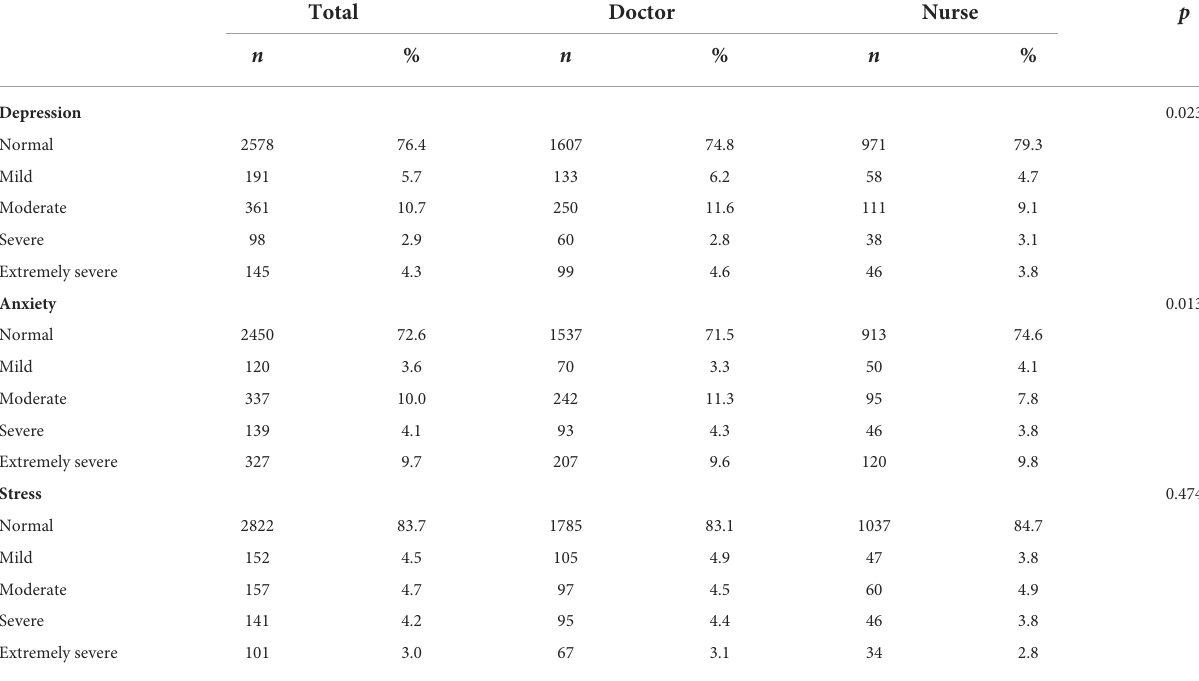
TABLE 2 Prevalence of depression, anxiety and stress symptoms in the